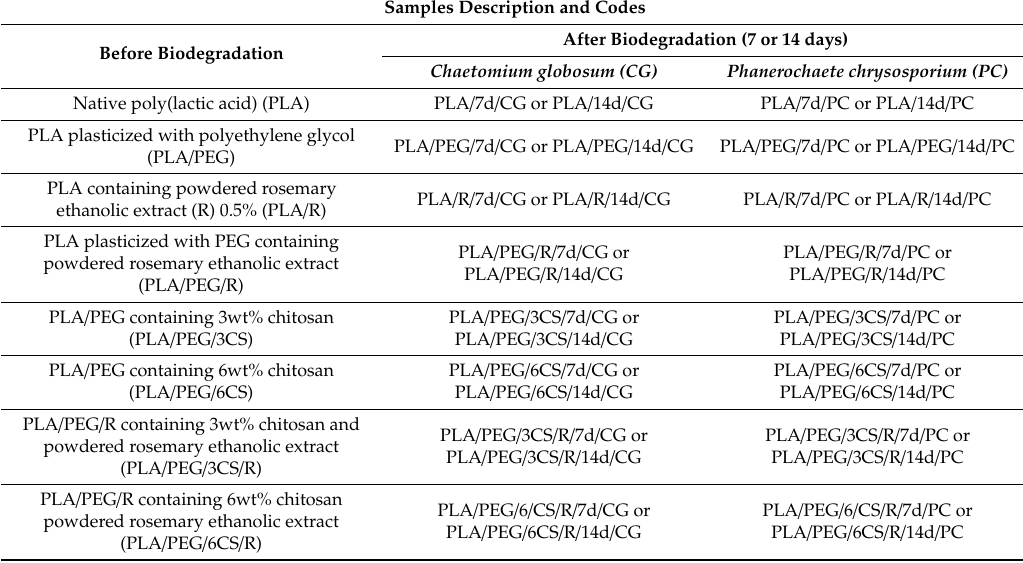
Table 1. Poly(lactic acid) (PLA)-based samples that were exposed to fungal